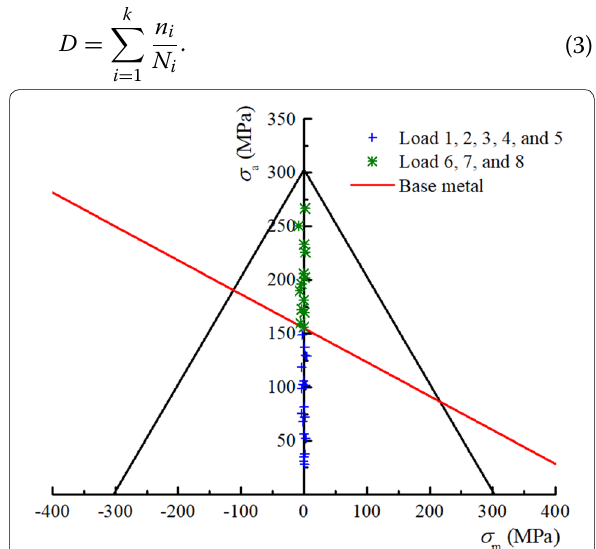
Figure 12 Goodman diagram for brake unit bracket under the eight-stage braking load